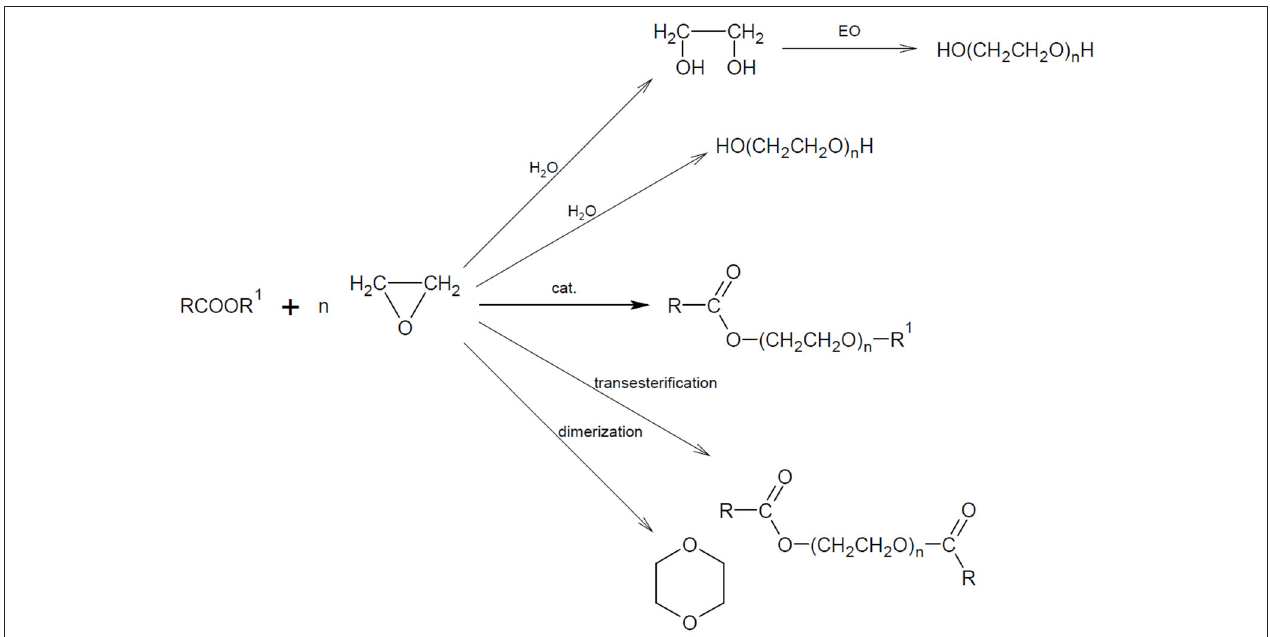
FIGURE 2 | Possible side reactions during the ester ethoxylation process.